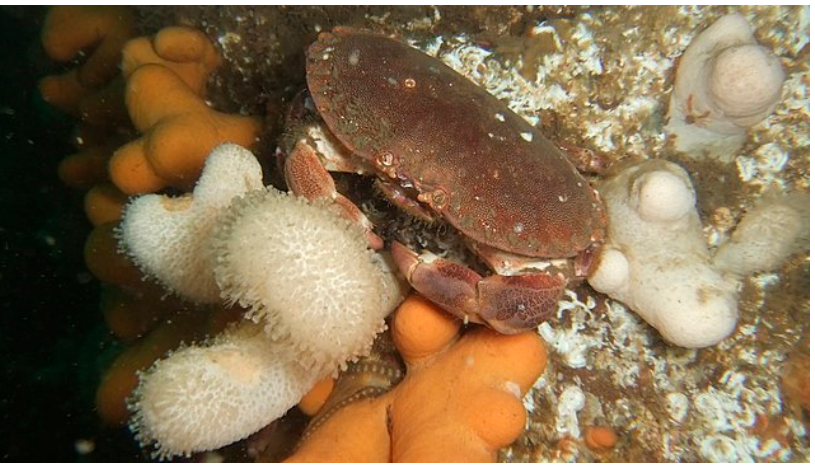
Figure 1. The brown crab ( Cancer pagurus ). Reproduced with permission from [23], licensed under CC BY 2.0. Chronic consumption of cadmium due to a cumulative dietary intake from cad- mium-exposed foods is dangerous and carries a serious risk of toxicity [24]. Although cadmium toxicity is extremely rare in modern times [25], monitoring cadmium levels in various foods is nevertheless a critical safety net to maintain health.